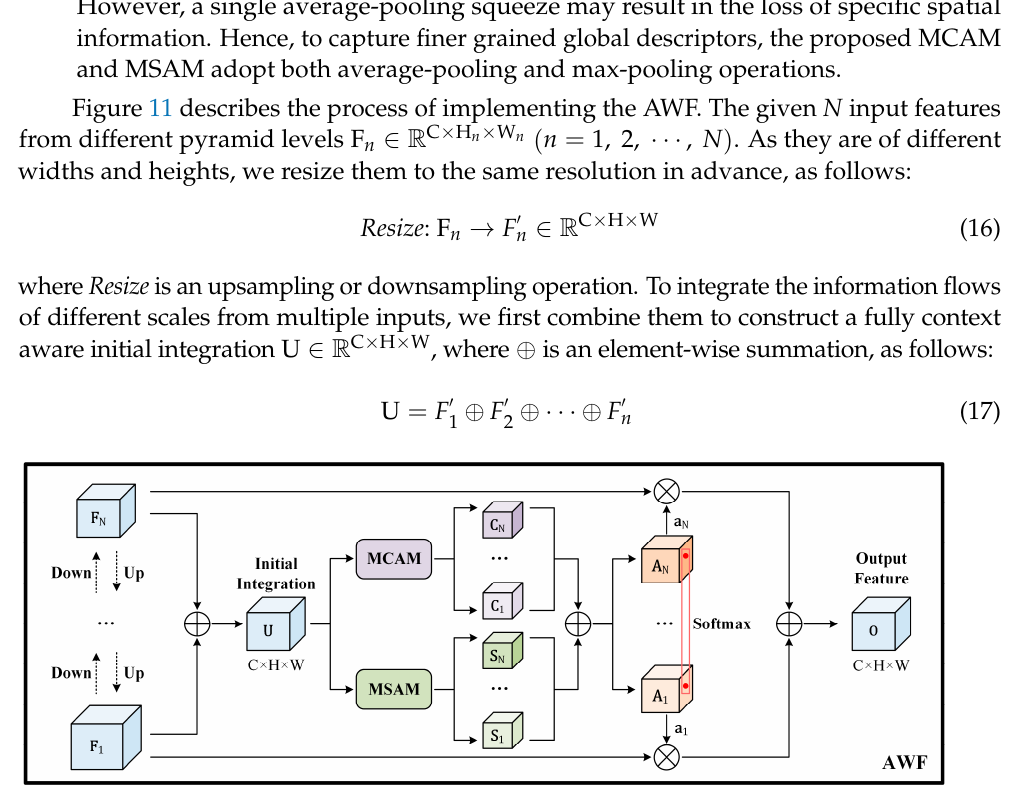
Figure 12. Diagram of each attention sub-module. Multi-scale feature contexts are aggregated in both MCAM and MSAM.